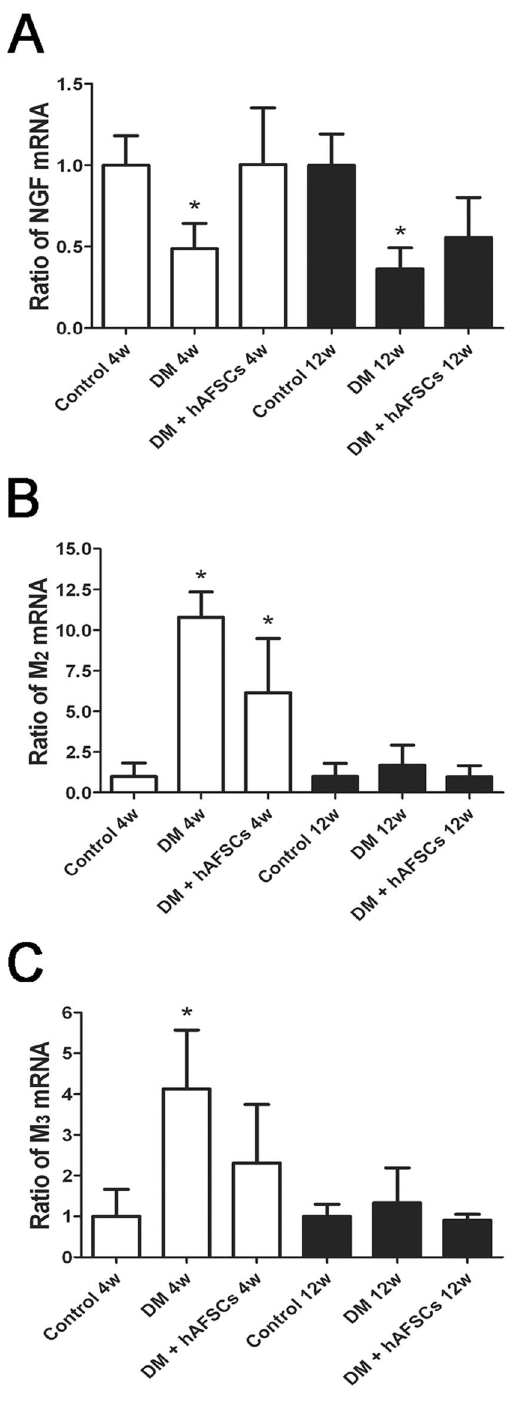
Figure 3. Relative mRNA expressions of nerve growth factor (NGF, A ), M2-muscarinic receptor (M2, B ) and M3-muscarinic receptor (M3, C ) in the bladder of control, STZ-induced diabetic rats (DM) and diabetic rats + hAFSCs transplantation (DM + hAFSCs). Expressions of M2 and M3 mRNAs are increased, and expression of NGF mRNA is decreased in the diabetic rats at week 4 and 12 as compared to controls. After hAFSCs transplantation, expressions of NGF, M2 and M3 recover to near the control levels. Bar indicates 20 μ m. * P < 0.05 vs. control group. N = 10 in each time